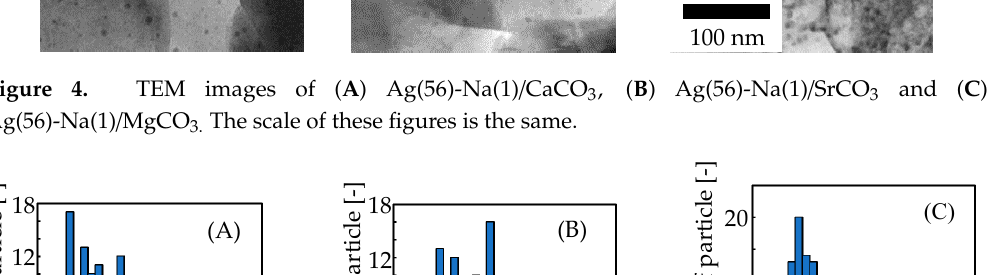
Figure 4. TEM images of ( A ) Ag(56)-Na(1)/CaCO 3 , ( B ) Ag(56)-Na(1)/SrCO 3 and ( C ) Ag(56)-Na(1)/MgCO 3. The scale of these figures is the same.